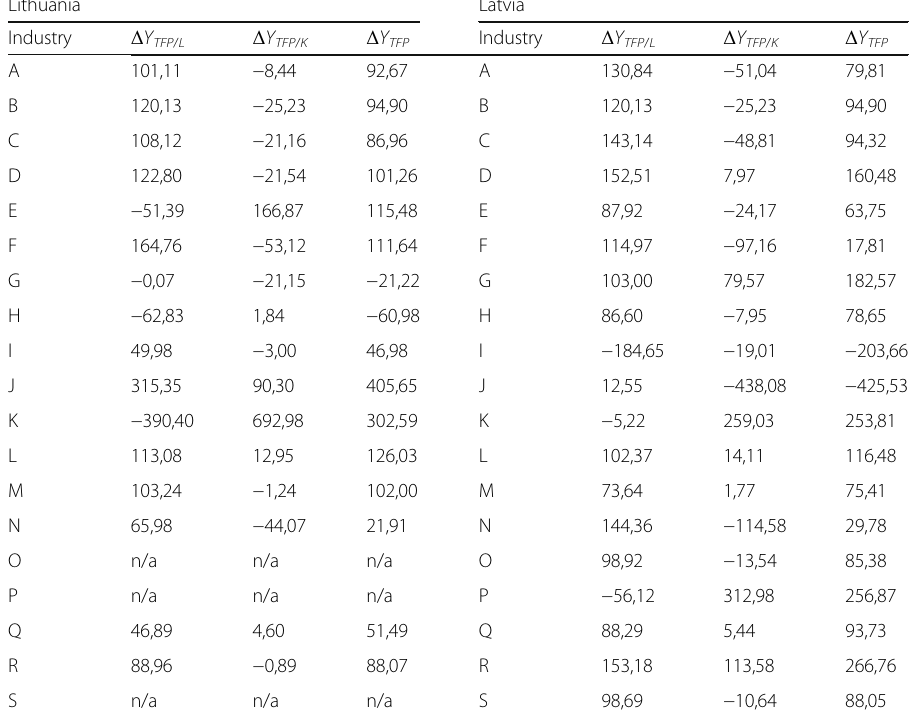
Table 1 The results of the total factor productivity calculation (Source: compiled by authors based on author ’ s calculations)